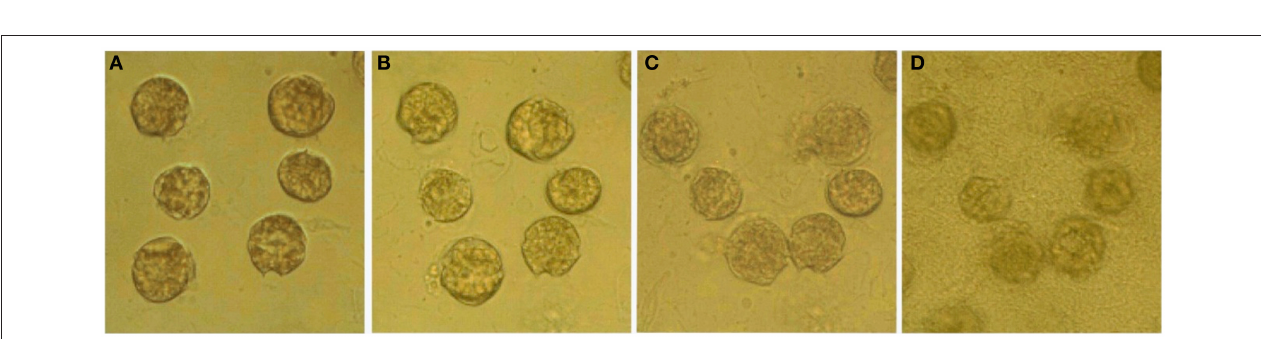
FIGURE 5 | Phylogenetic tree of the ingested bacteria. Phylogenetic tree based on a comparison of the 16S rRNA gene sequences, indicating the phylogenetic position of the strains isolated (isolation 1, 2, and 3) from flagellate culture. The phylogenetic tree was generated using the neighbor-joining method. Bootstrap values, expressed as percentages of 1000 replications, are given at the branching points. The scale bar indicates substitutions per nucleotide position.